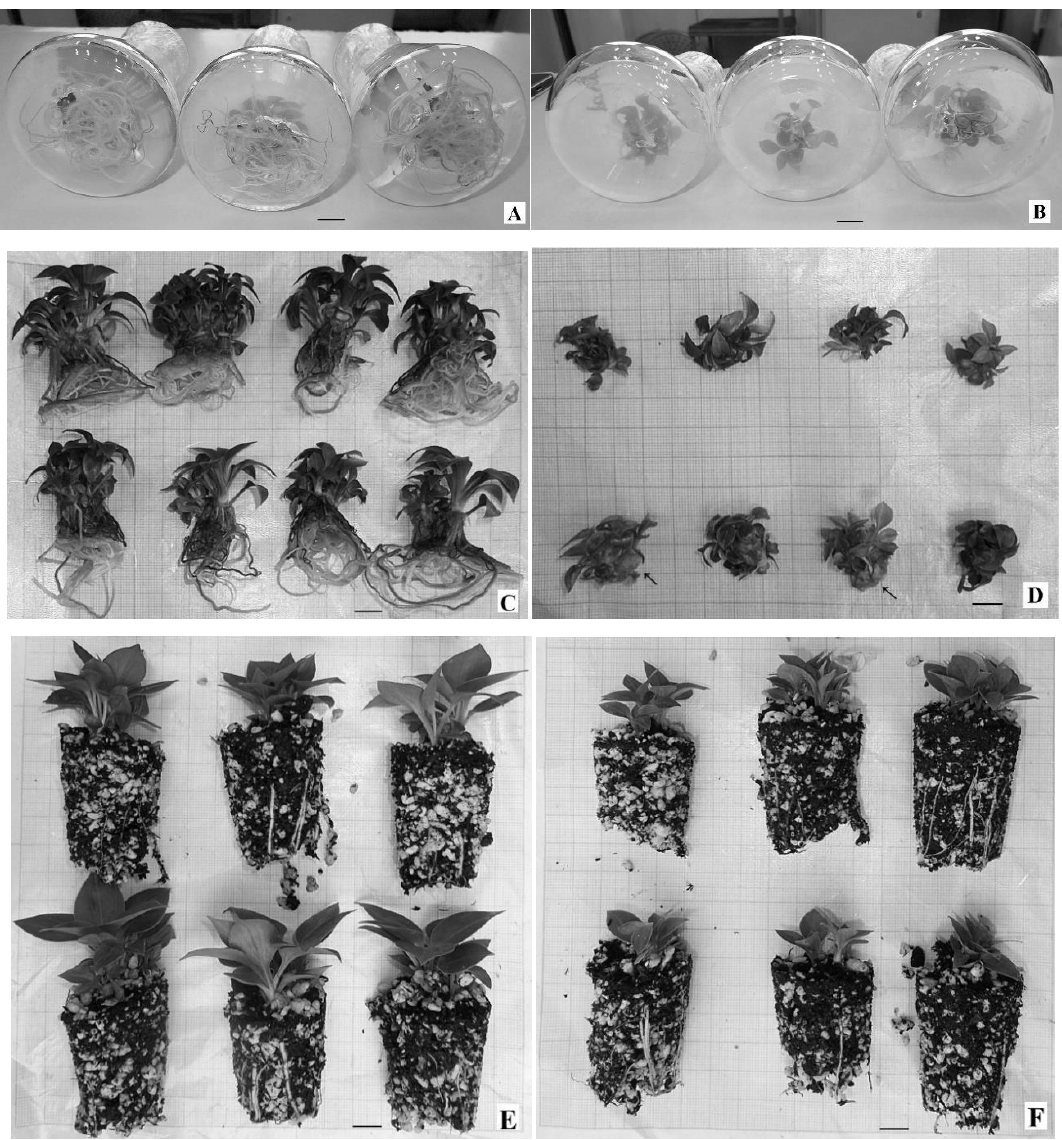
Figure 1. Hosta ’Gold Drop’ in vitro and acclimatized (ex vitro ) plants: A) Well rooted specimens in 100 ml Erlenmeyer flasks containing ½ MS medium with 0.4 ml l -1 Kelpak. (B) 0.8 ml l -1 Pentakeep-V resulted plants without or only few, short roots. C) In vitro plants cultured on ½ MS medium supplemented with 0.4 ml l -1 Kelpak produced more and longer shoots with larger leaves. D) Poorly developed in vitro plants (callus formation shown by arrows) from ½ MS medium containing 0.8 ml l -1 Pentakeep-V. E) Ex vitro plants grown better when Kelpak was used before acclimatization. F) As after-effect, Pentakeep resulted weaker ex vitro plants. Scale bars on pictures: 10